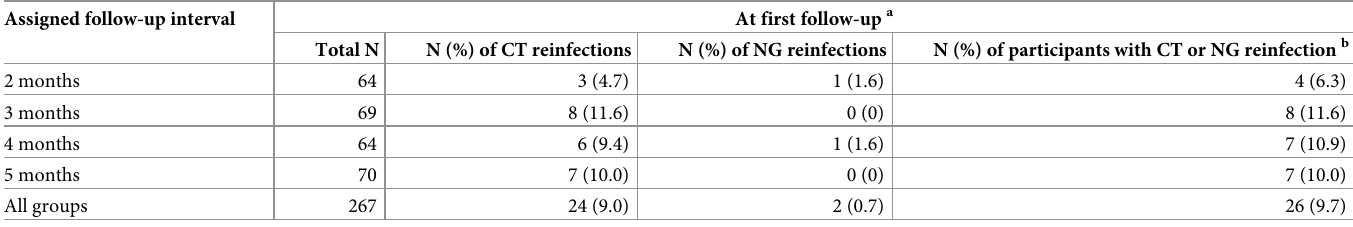
Table 3. Incidence of reinfection with Chlamydia trachomatis or Neisseria gonorrhoeae . Assigned follow-up